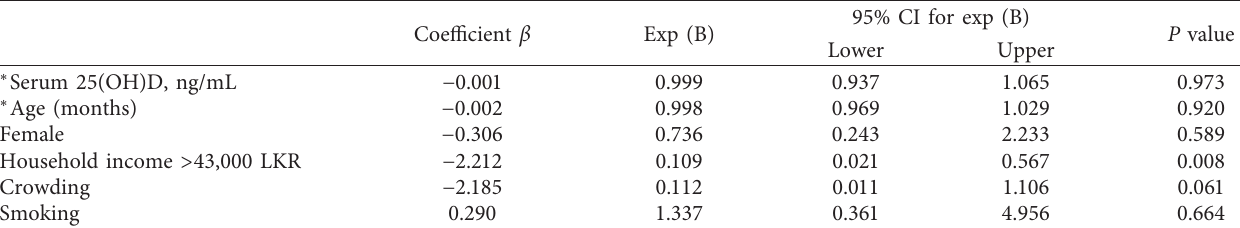
Table 3: Multivariate analysis of factors associated CAP with unconditional logistic regression taking cases and controls as the dependent